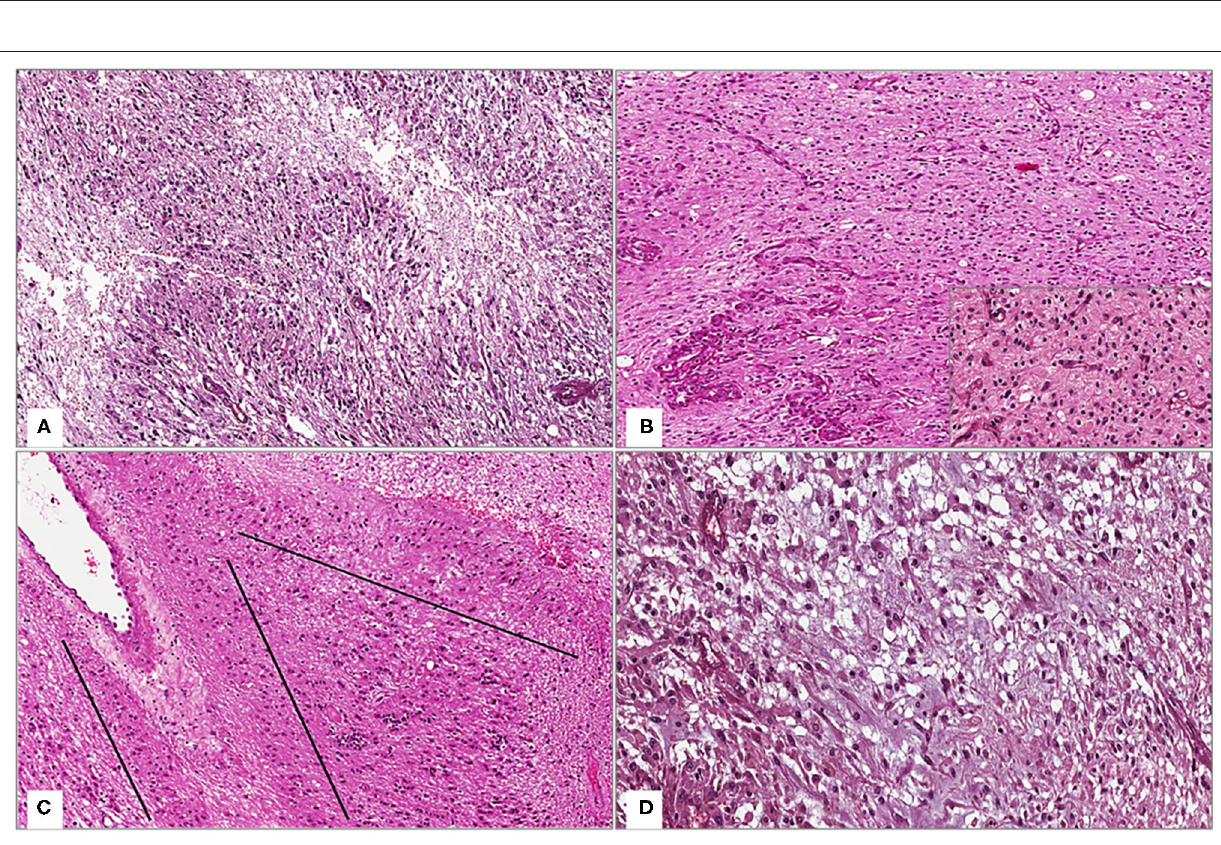
Frontiers in Neurology |